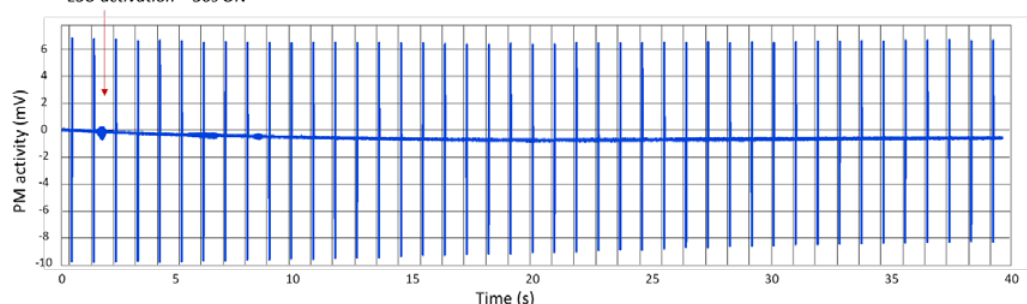
Figure 5. Example of PM activity recorded during the activation of the ESU (ON for about 30 s). No changes of the pacing rate or in the programmed parameters were observed.